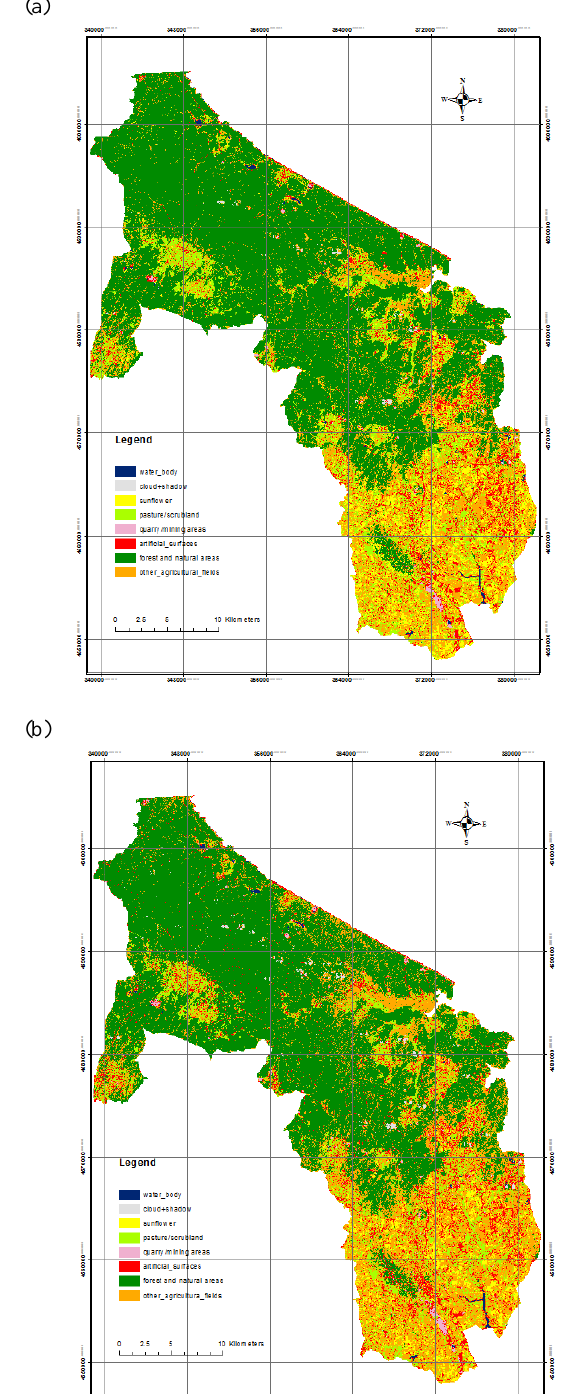
Figure 3. Land Use/Land Cover Classification with Highest Accuracy for: (a) SVM, and (b) MLC An accuracy assessment was evaluated for all classification using a standart error matrix. Overall accuracy and kappa statistics were used to compared to determine the performance of the classification results for the selected heterogeneous region (Table